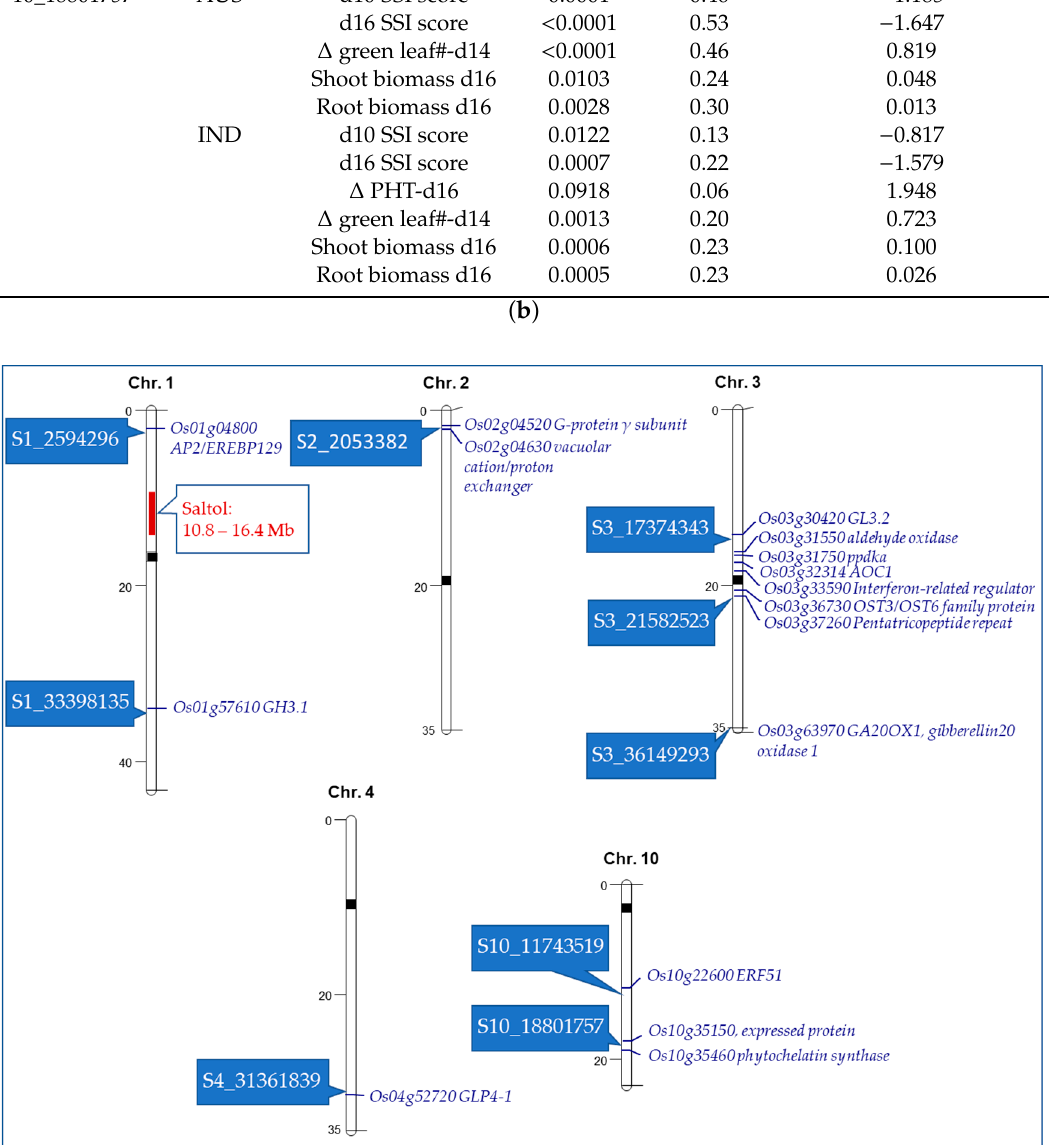
Figure 3. Physical location of candidate genes on five rice chromosomes based on identified SNPs associated with various salt tolerant traits at the seedling stage. Saltol, a major quantitative trait loci (QTL) [20], is shown for reference. SNPs are shown in rectangular boxes on the left side of the chromosomes. The candidate genes are shown in italics on the right side of the chromosomes.